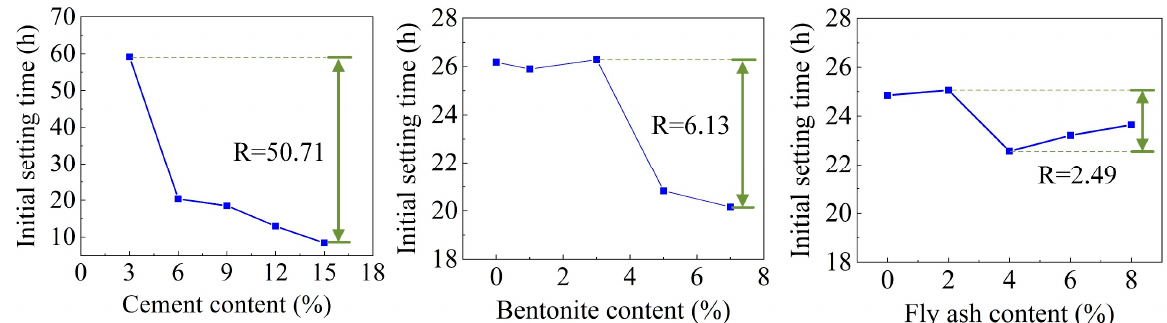
Figure 11. Test results of initial setting time.